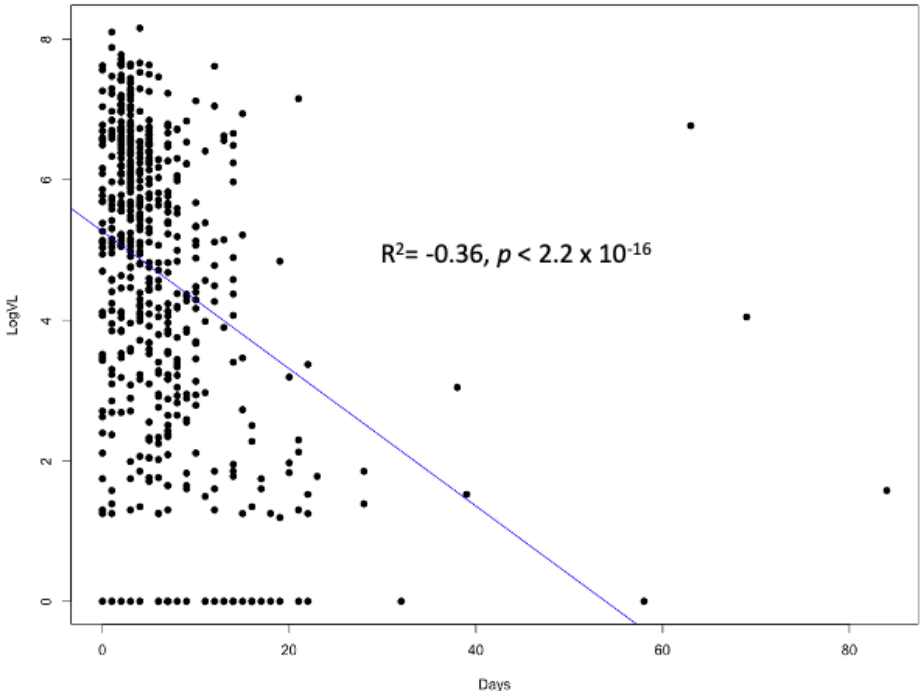
Figure 1. Scatterplot of Log10 SARS-CoV-2 viral load vs. days between onset of symptoms and na- sopharyngeal sample collection. Spearman rho = − 0.39, with p -value < 0.00001. Table 5. Univariate logistic regression for COVID-19-related